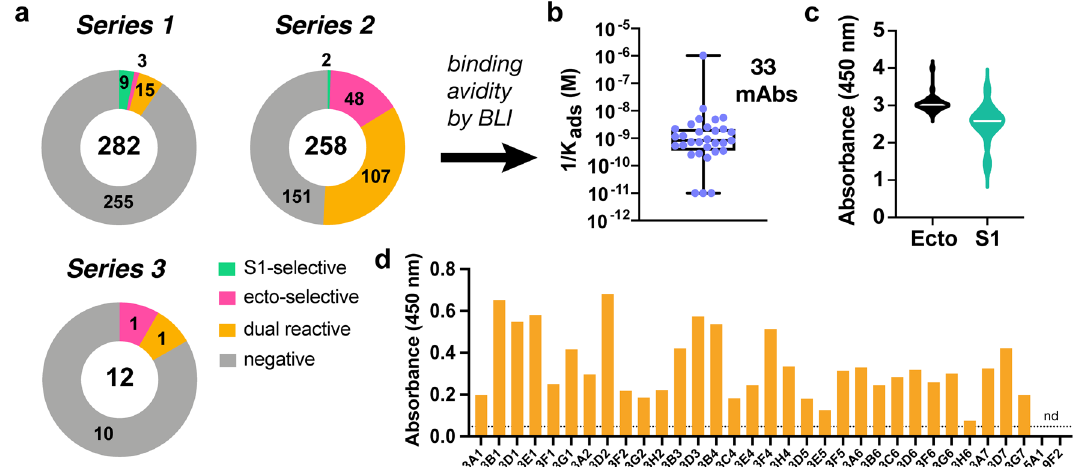
Figure 2. Characterization of anti-SARS-COV-2 antibodies as supernatants from hybridoma clones. ( a ) Antigen specificity of antibody binding from IgG-secreting hybridomas chosen from Series 1–3 immunization schedules. Numbers inside circles are total clones selected, numbers within each portion reflect binding selectivity. ( b ) Distribution of affinities of the 33 selected clones as measured by BLI. ( c ) Binding to two different Spike recombinant proteins (ecto Spike trimer and S1 polypeptide) as determined by ELISA. ( d ) Binding of antibodies to γ-irradiated WA-SARS-CoV-2 by ELISA (15 ng/mL virus plated, supernatant undiluted, secondary antibody = goat anti-mouse IgG HRP conjugate).